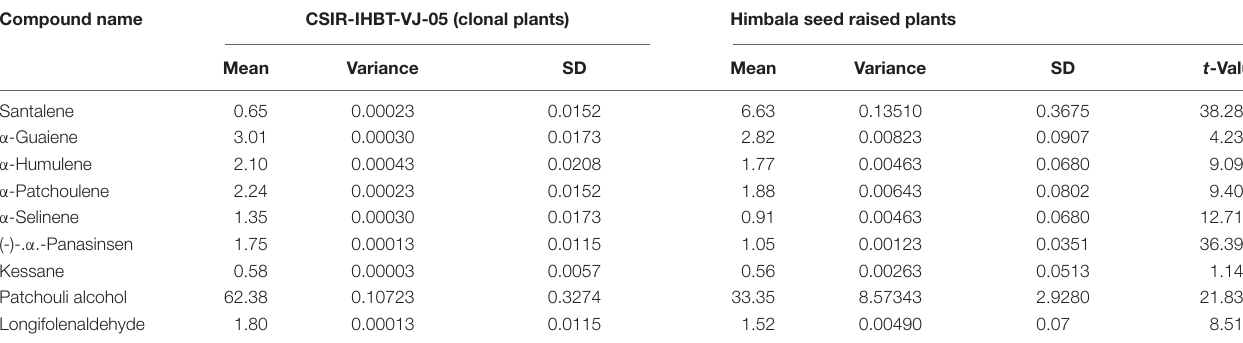
TABLE 6 | Variation of essential oil compounds in a vegetatively propagated clone of CSIR-IHBT-VJ-05 and seed raised plants of